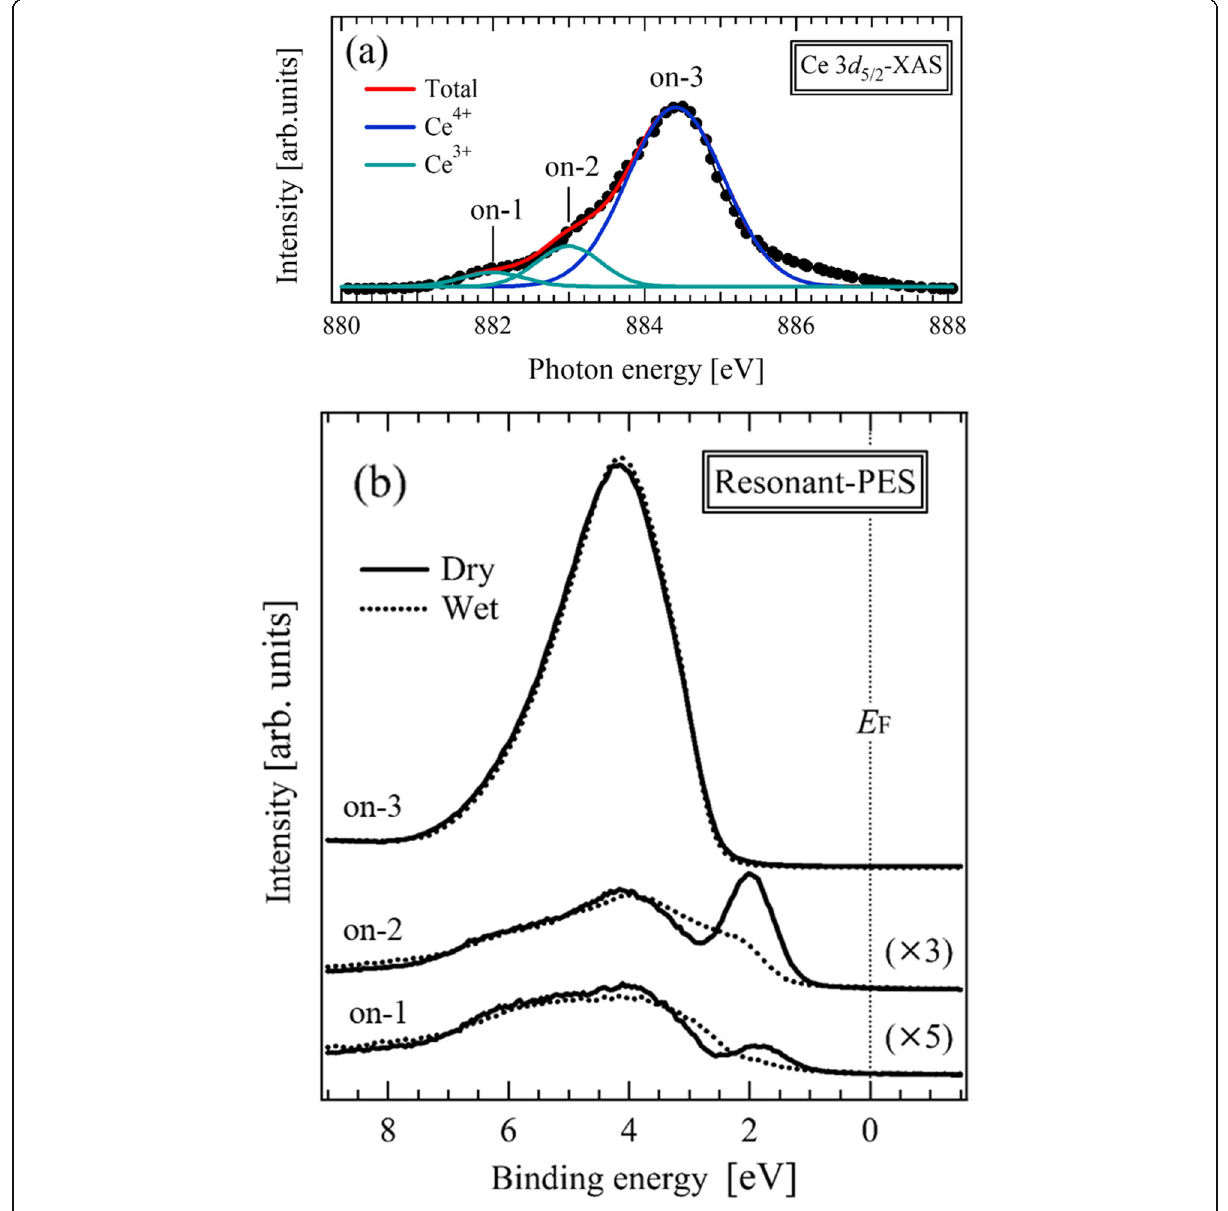
Fig. 2 a Ce 3 d XAS spectrum of the as-deposited SDC thin film. The labels on-1, on-2, and on-3 indicate the excitation energies for the resonant PES measurements. b Resonant PES spectra of the as-deposited and wet-annealed SDC thin films measured at on-1, on-2, and on-3 in a . The green and blue curves are the Ce 3+ and Ce 4+ states, respectively, obtained from Gaussian